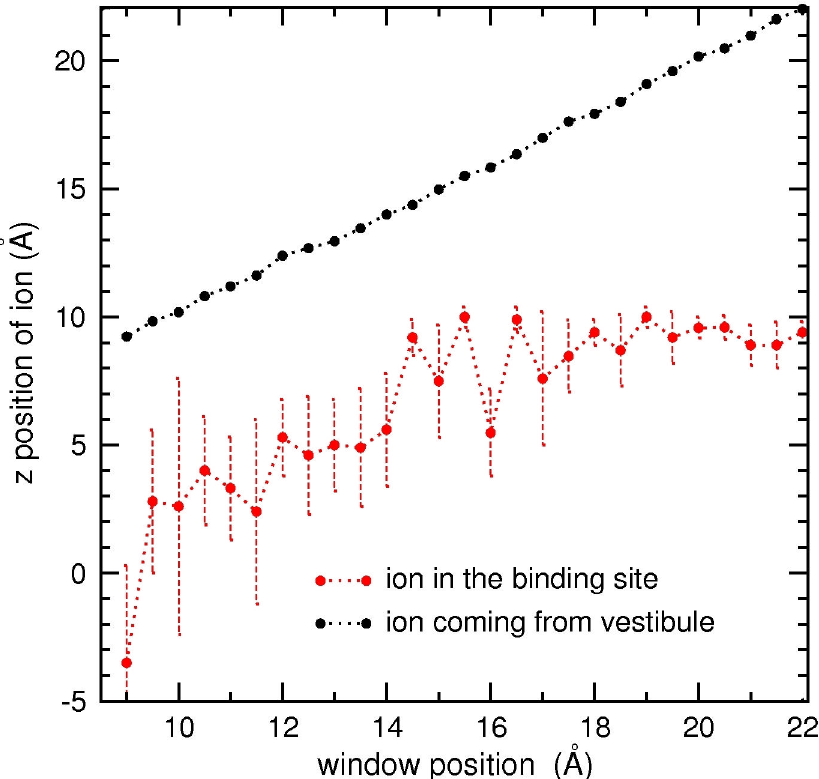
Fig 10. Correlated motion of two Na + ions in the pore depicting the knock-on mechanism. Changes in the average z -position and fluctuations of the Na + ion in the SF binding site (red dots and dotted lines) while a second Na + ion is moved from the vestibule to the SF in umbrella sampling simulations (the z -coordinate is indicated by black